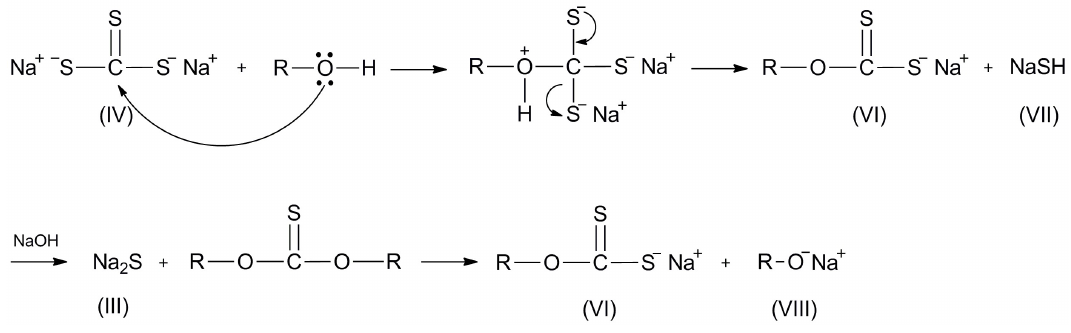
Figure 6. Reaction of degradation of the by-products of tritiocarbonate and disulfide in xanthate synthesis.